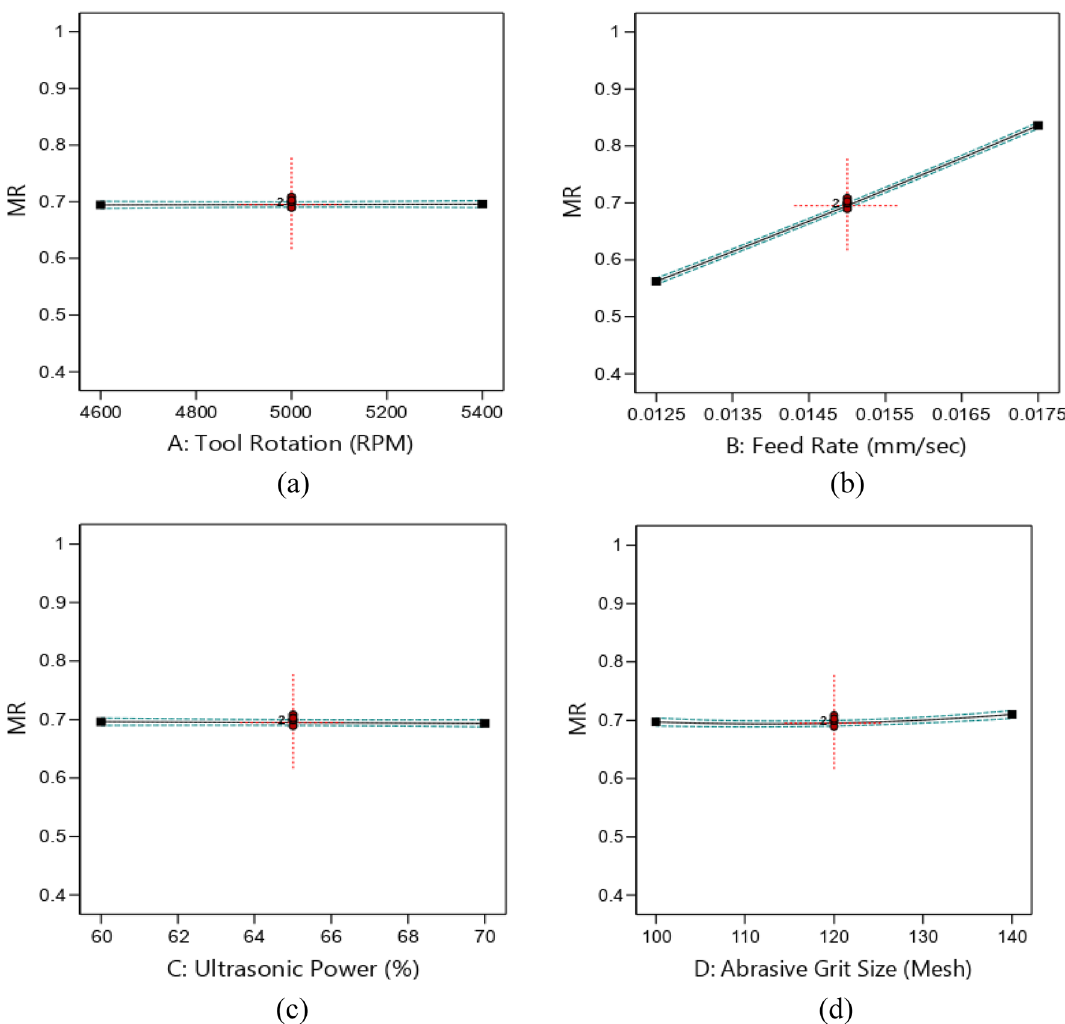
Figure 9. Effects of RUM parameters on MR ( a ) rotational speed, ( b ) feed rate, ( c ) ultrasonic power, ( d ) abrasive grit